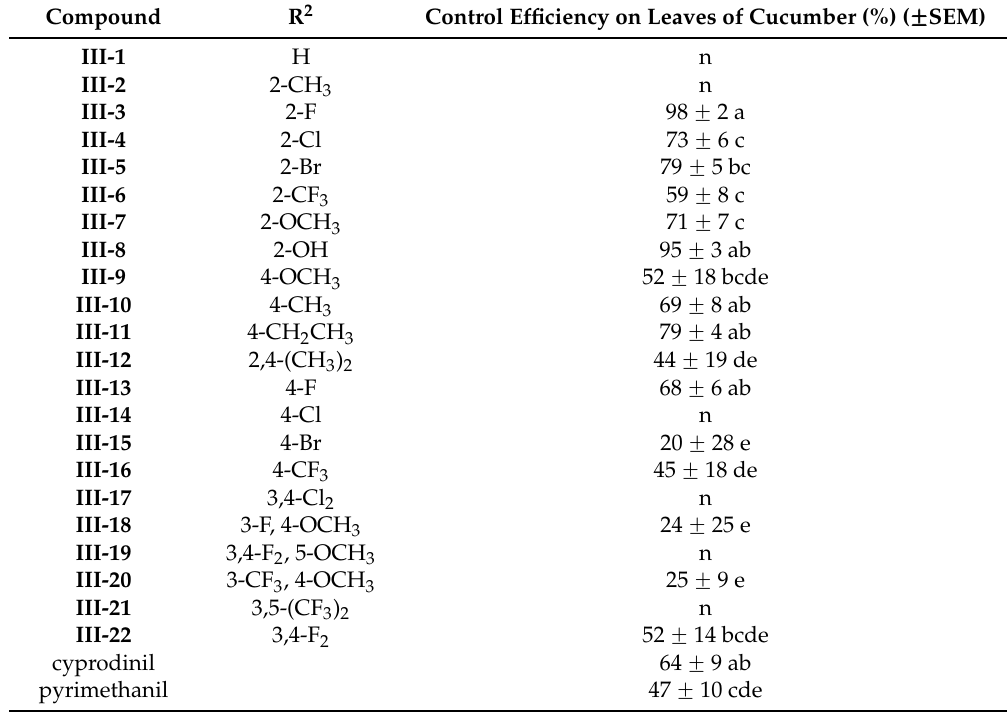
Table 2. Control efficiency of compounds III-1 – III-22 against B . cinerea at 750 µ g/mL (mycelium inoculation